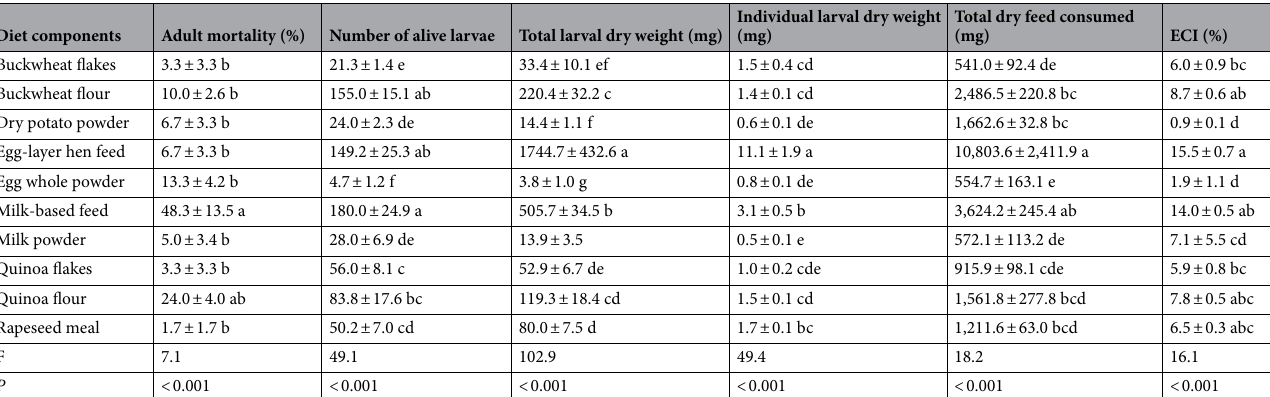
Table 6. Adult mortality (%) (after 1-week), number of alive larvae, total larval dry weight (mg), mean individual larval dry weight, total dry feed consumed (mg), and efficiency of ingested food conversion (ECI, %) of Tenebrio molitor larvae fed on various substrates of vegetative or animal origin for 10 weeks. In all cases, values represent means ± SEM (n = 6). Within each column, means followed by the same lowercase letter are not significantly different (in all cases df = 9, 59; Tukey–Kramer HSD test at P = 0.05. Where no letters exist, no significant differences were